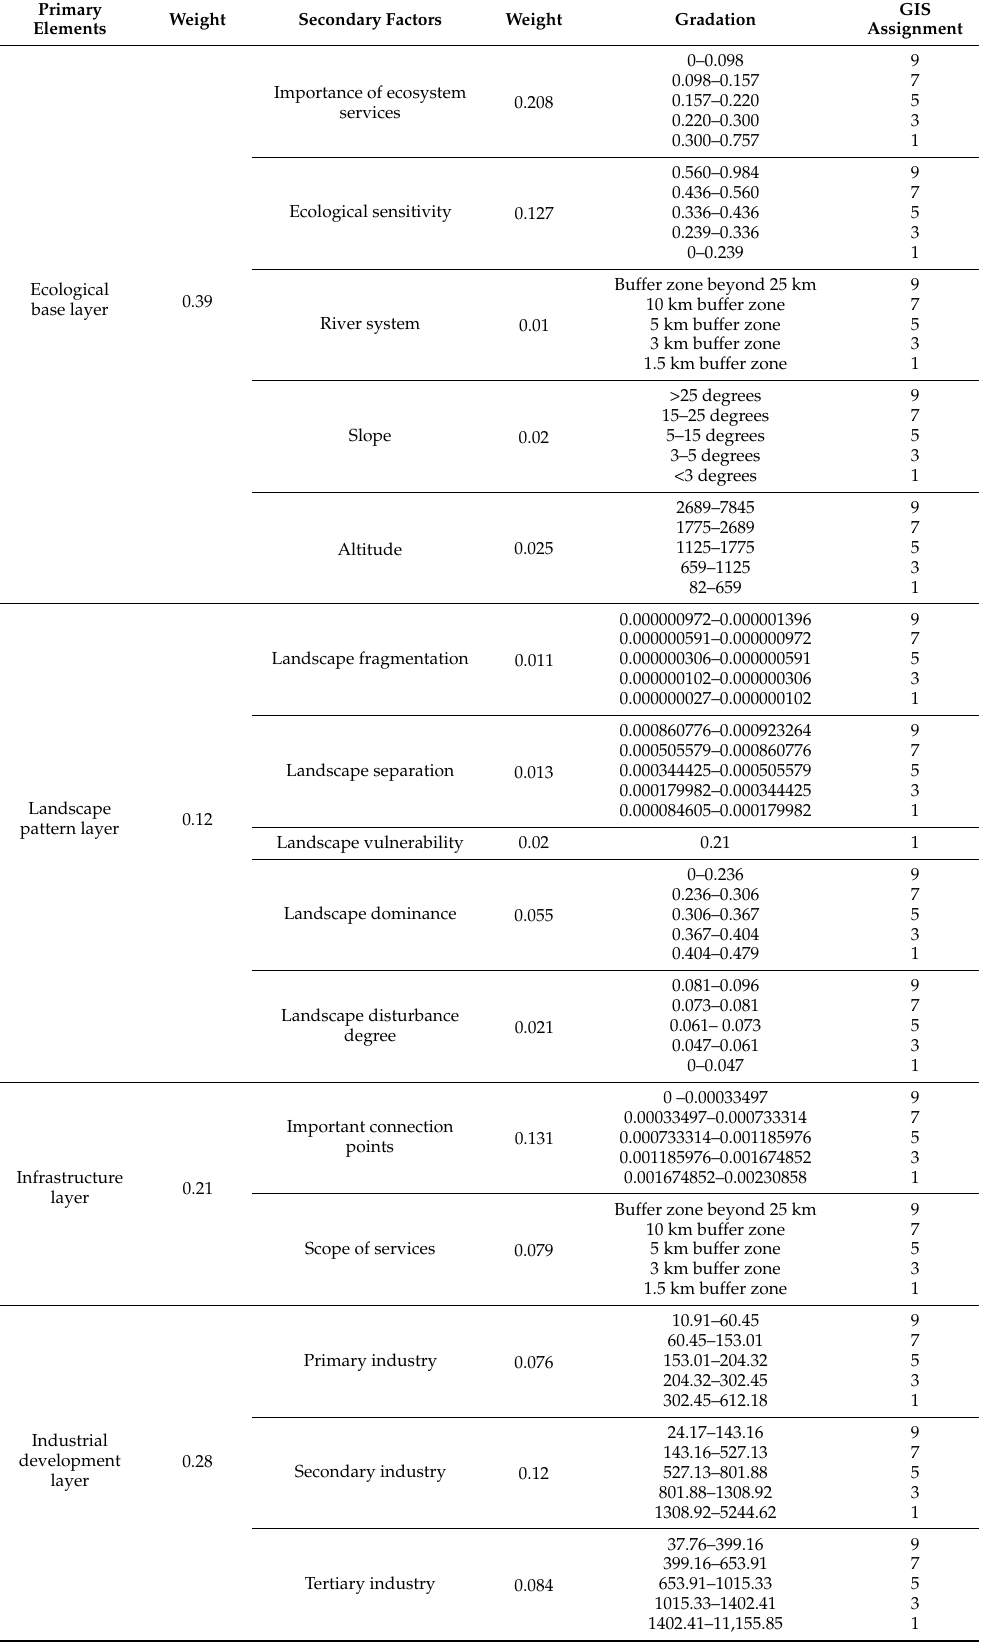
Table 3. Evaluation system for the construction of the bamboo scenic line in Sichuan